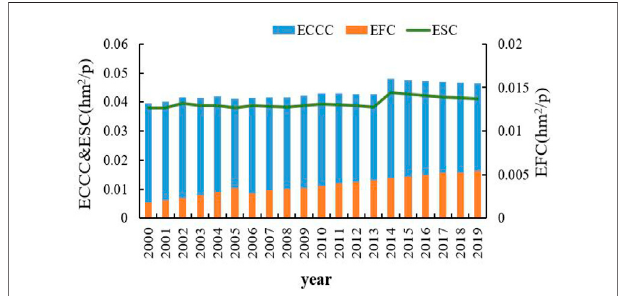
FIGURE 4 | 2000 – 2019 ECCC, EFC, and ESC of waters areas in Sichuan province.